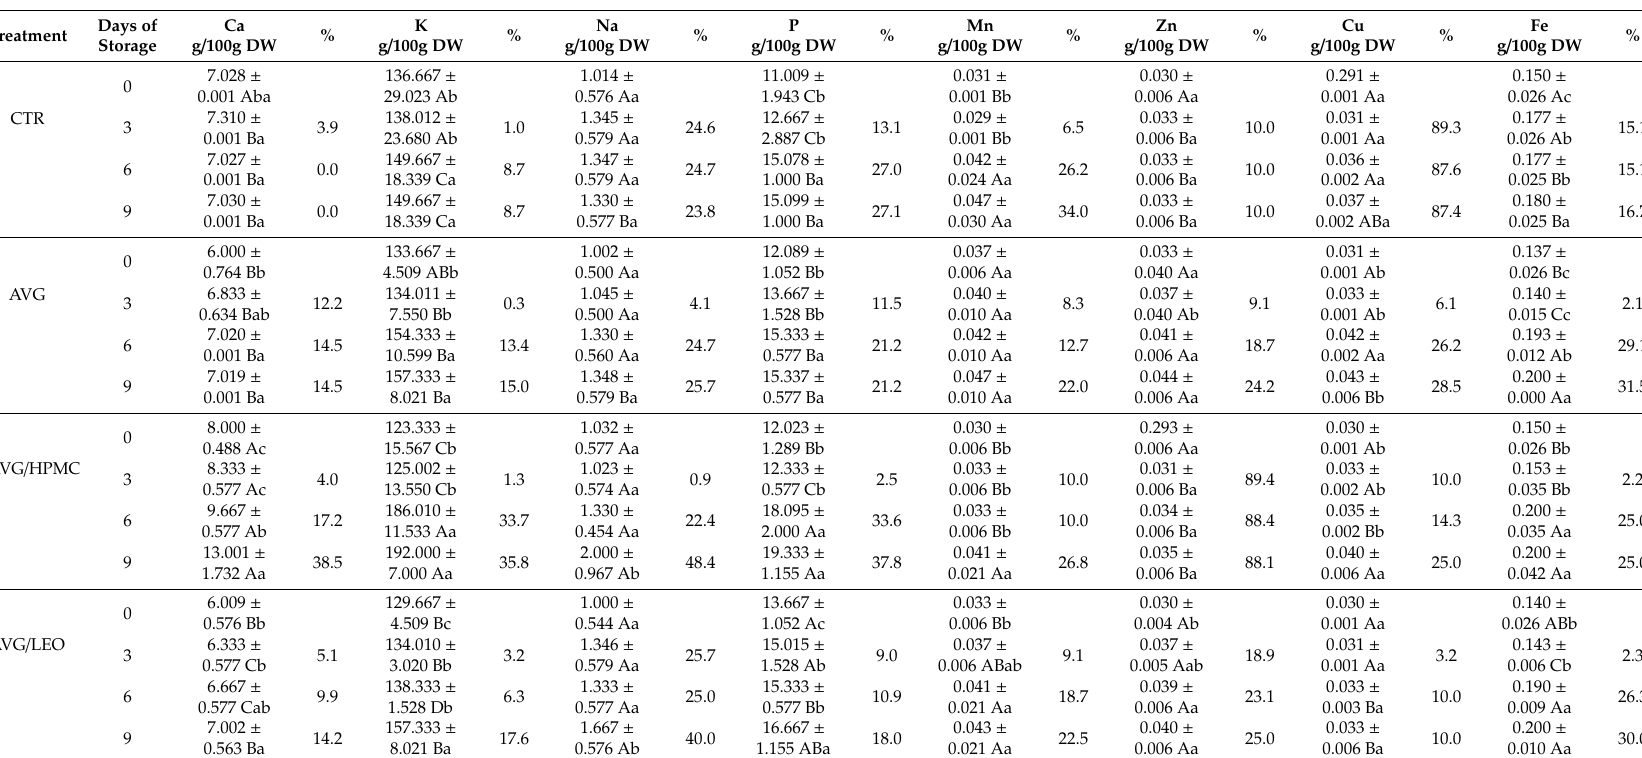
Table 3. Ca, K, Na, P, Mn, Zn, Cu, and Fe in fresh-cut apples at 0, 3, 6, and 9 days of storage at 4 ◦ ± 1 ◦ C and 90% ± 5% RH after all treatments.